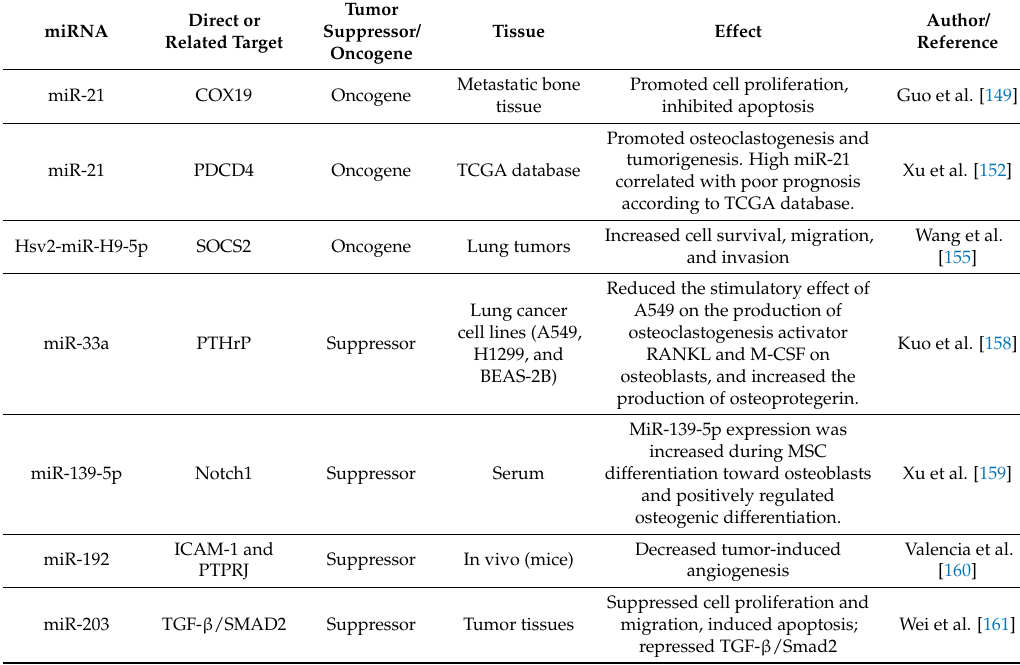
Table 2. Bone metastasis-related miRNAs in